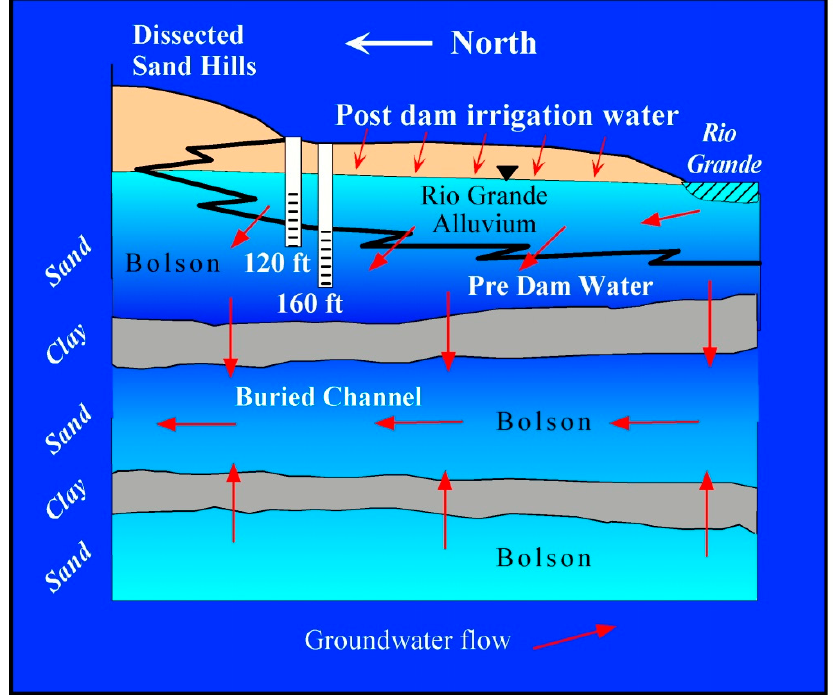
Figure 7. Conceptual model for groundwater flow to a deeper buried channel in the study area. The diagram frames isotope data and hydrogeologic setting at Oro Well 1 (120 ft deep) and Oro Well 2 (160 ft) in the conceptual framework image.